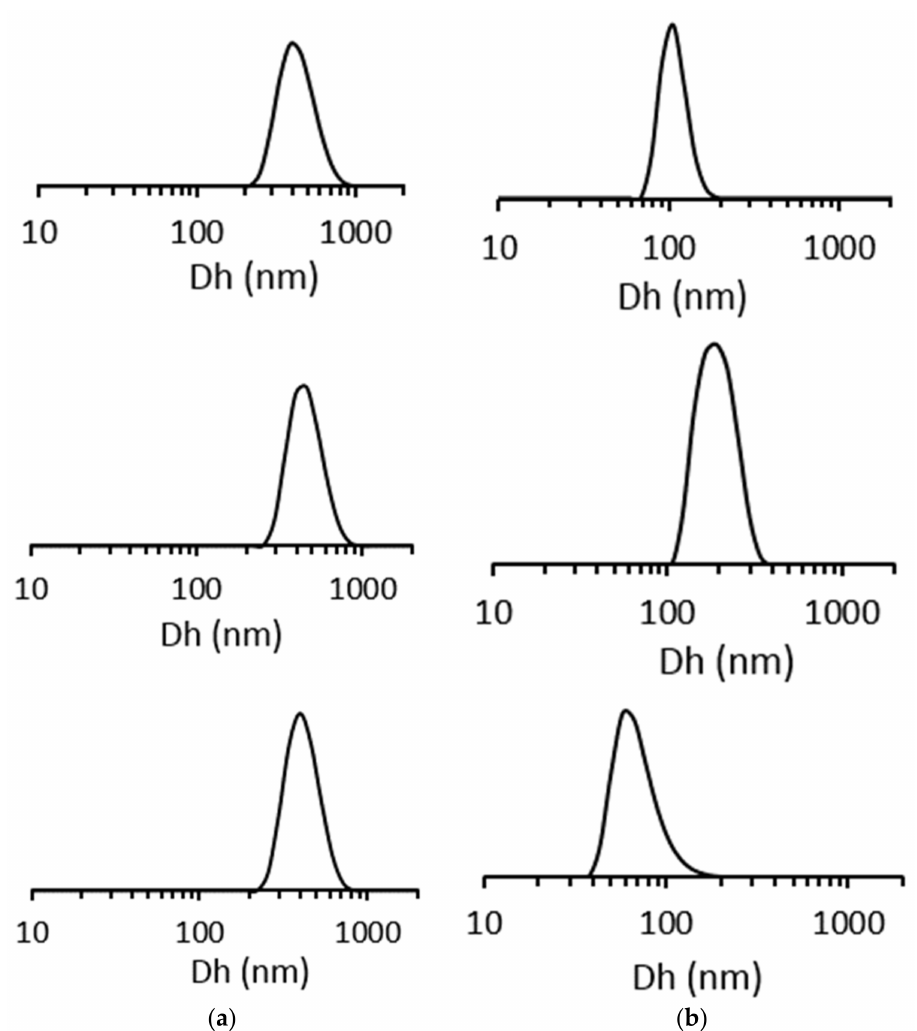
Figure 6. From top to bottom: size (hydrodynamic radius) distribution (in number) obtained by DLS for SiO 2 , SiO 2 @CN , SiO 2 @COOH beads from SiO 2 beads produced in EtOH ( a ) and MeOH ( b